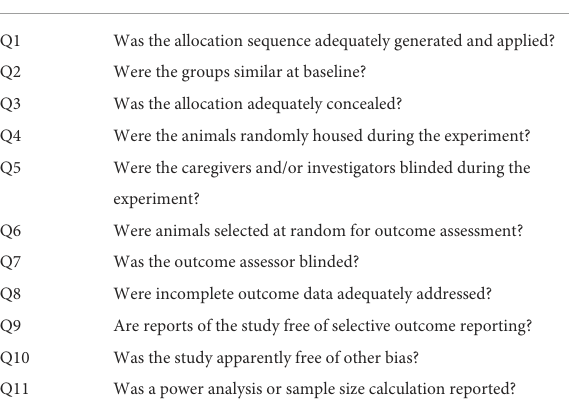
TABLE 2 SYRCLE’s risk of bias tool signaling questions